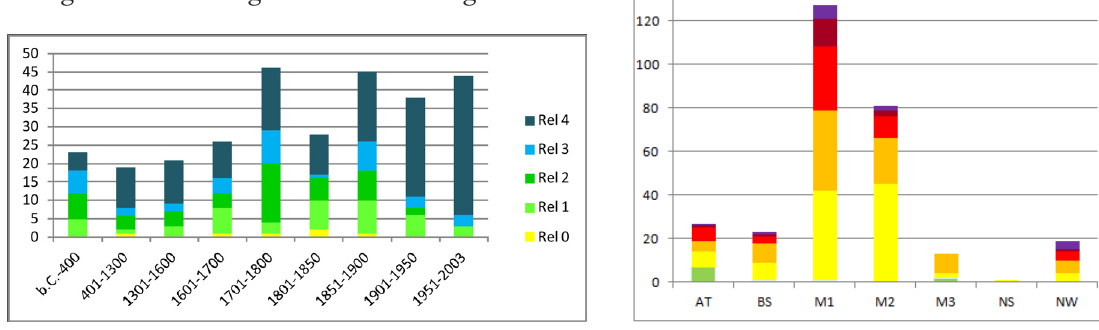
Figure 5. Time distribution of the tsunamis per reliability classes. Figure 6. Regional distribution of the tsunamis per intensity classes.